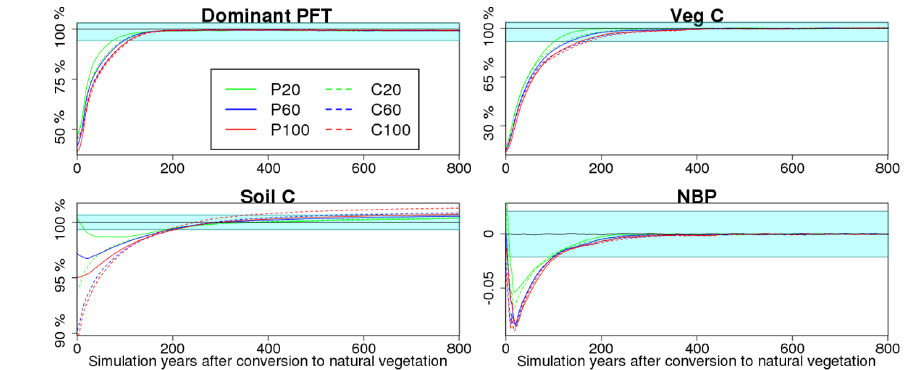
Figure 2. Time series (20-year running mean) of dominant PFT, vegetation C, soil C and NBP for the different experiments, starting from the time of reconversion to natural vegetation and area-averaged over all grid cells. Dominant PFT, vegetation C and soil C are shown in relative values compared to reference simulation mean, while NBP is shown as absolute values (kgCm − 2 yr − 1 ) because values cannot be presented relative to a zero background. The cyan-shaded area corresponds to reference simulation mean ± 1 σ . Note the different scales on the y